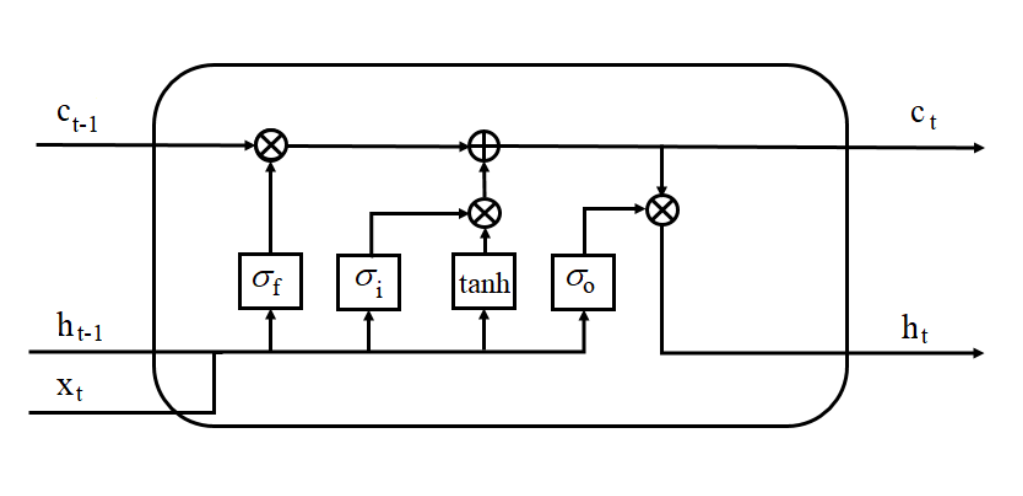
Figure 3. LSTM network